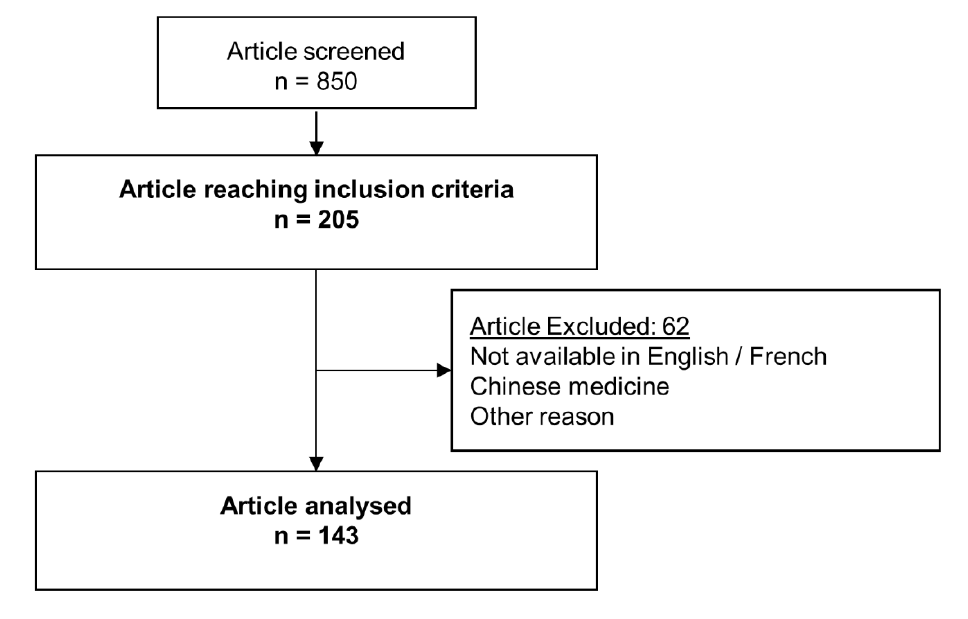
Figure 1. Flow chart study .